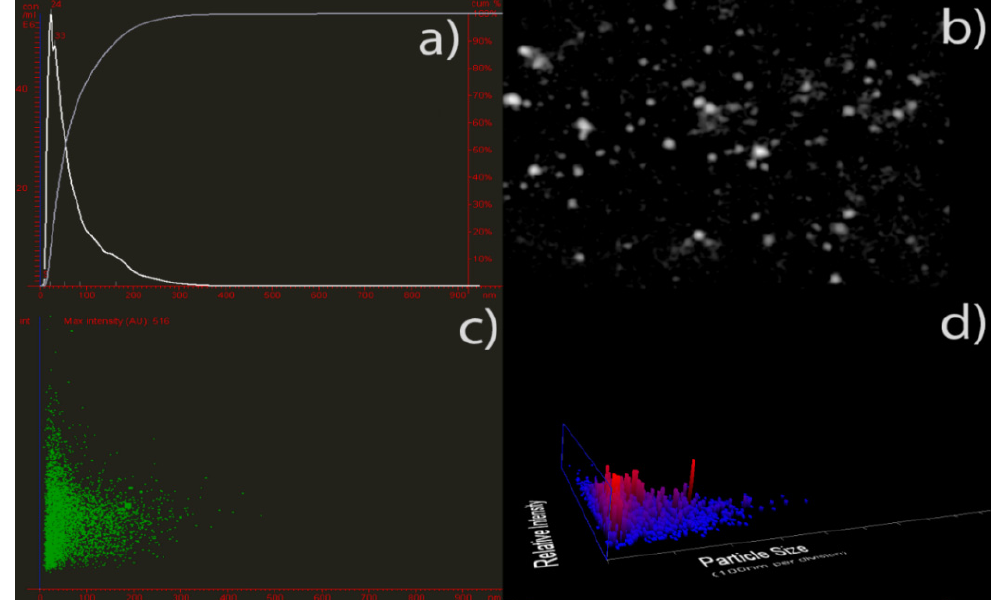
Figure 3. Nanoparticle tracking analysis of phytochemicals ‐ capped AgNPs. Particle size vs. the number of particles ( a ); representative nanoparticle tracking analysis video frame ( b ), particle size vs. relative intensity ( c ), and the number of particles vs. particle size and light scattering intensity (3D plot) are shown in ( d ).